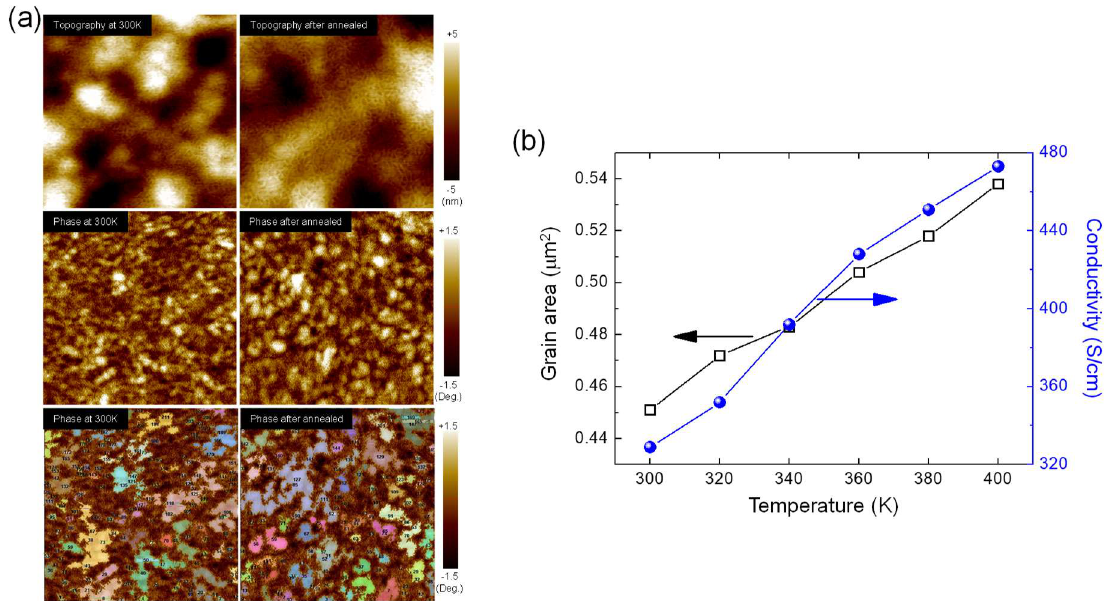
Figure 4. ( a ) AFM topography image (top), phase images (middle), and grain area calculation (bottom) of PEDOT:PSS film in of 1 × 1 μm 2 area obtained at 300 K and after being annealed at 400 K. ( b ) Plots of the total grain area of PEDOT cores and the conductivity of PEDOT:PSS film against temperature.